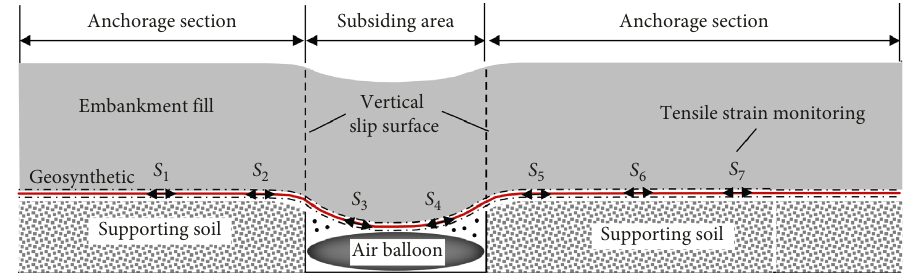
Figure 10: The air balloon trapdoor test carried out by Villard and Briançon [22].